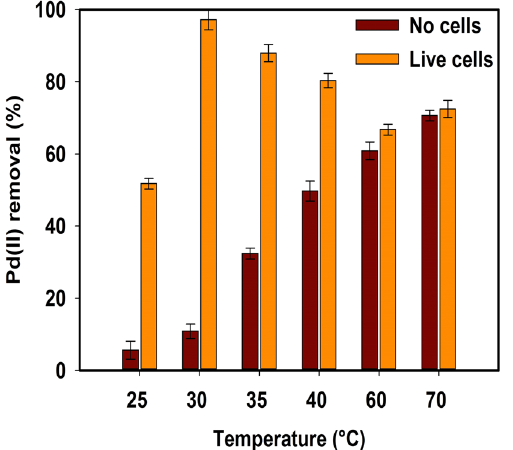
Figure 2. Temperature effect on the Pd(II) removal during Pd nanoparticles synthesis using no microbial cells and live microbial